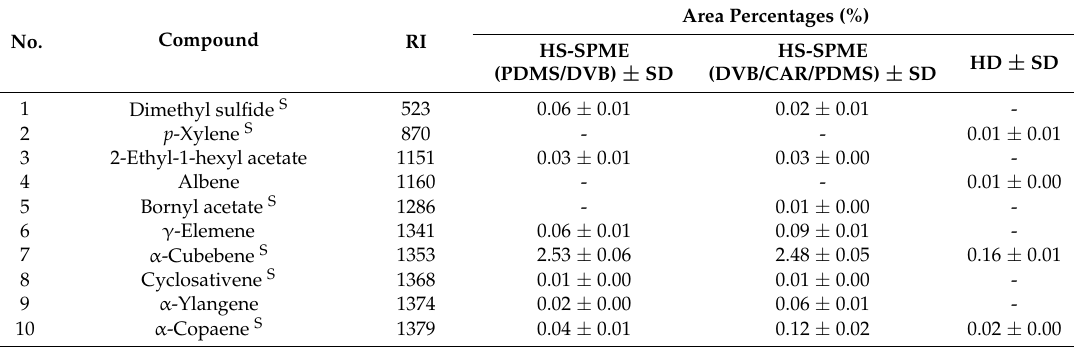
Table 1. Headspace and volatile oil composition of T. atomaria (RI from the literature used for identifying the